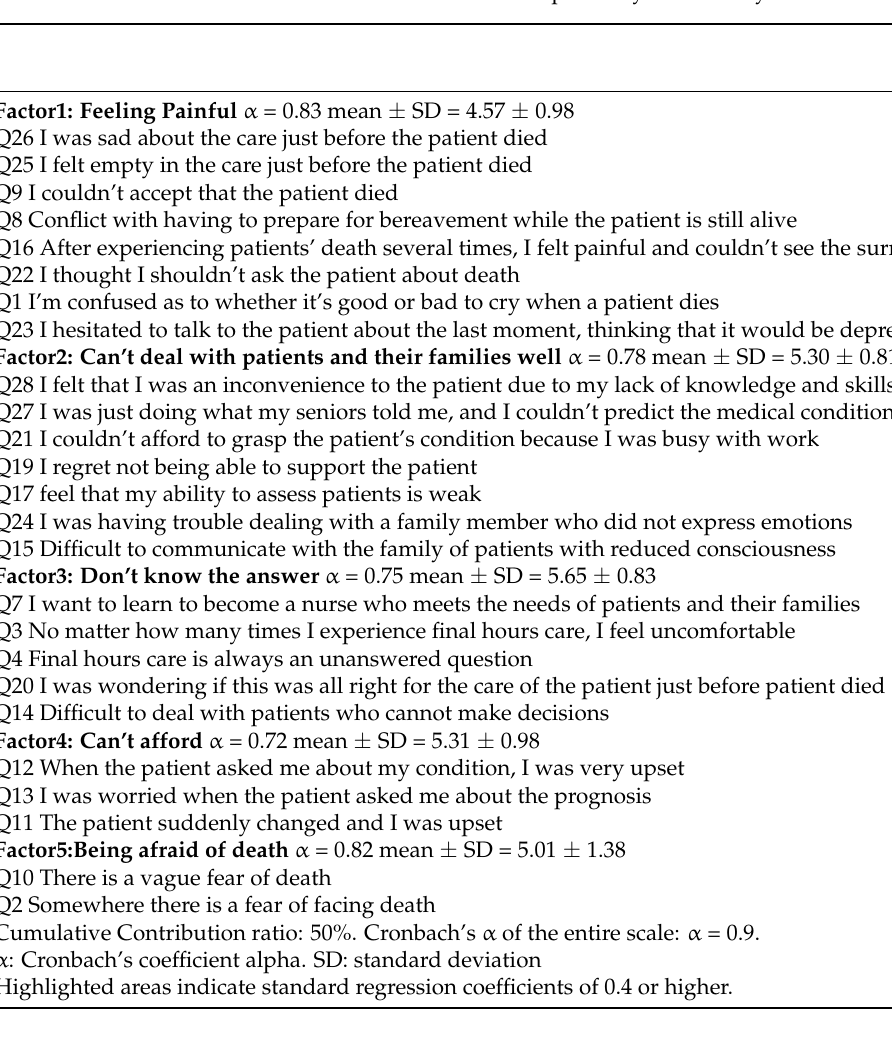
Table 2. Results of the exploratory factor